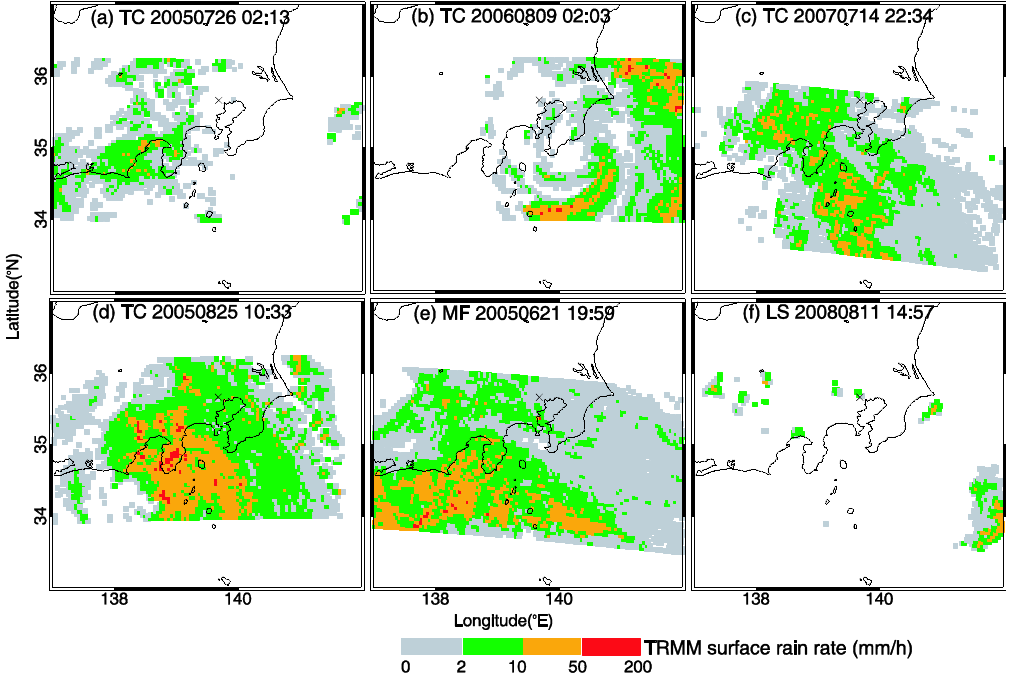
Figure 4. The surface rain rate of four tropical cyclones (TC) ( a – d ), one meiyu-baiu front (MF) ( e ) and one local storm (LS) ( f ) observed by 2A25 data of the precipitation radar (PR) on the Tropical Rainfall Measuring Mission (TRMM) satellite. The “X” denotes the location of Tokyo.